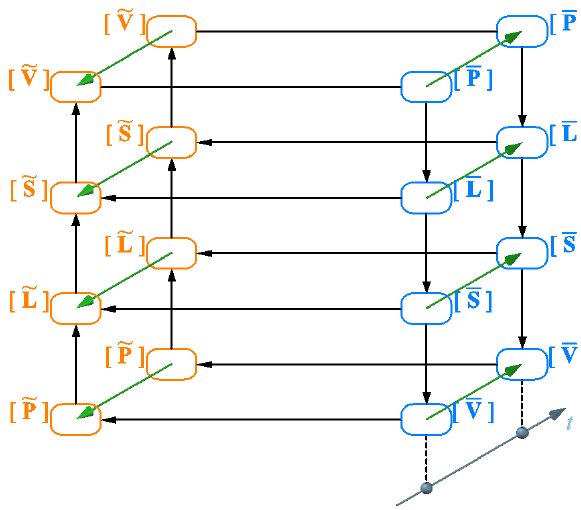
Figure 8: Space-times classification diagram of the physical vari-